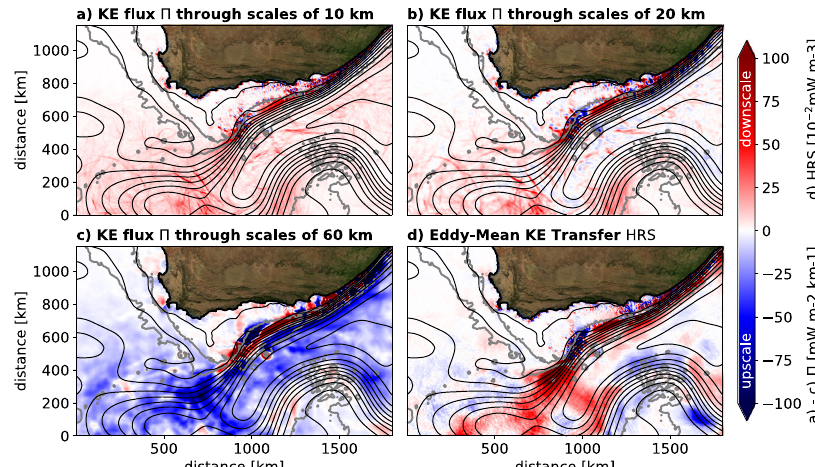
Fig. 4 Submesoscale fl ows strengthen shear-edge eddies and lee cyclones. The mean surface kinetic energy fl ux Π through horizontal scales of ( a ) 10 km, ( b ) 20 km, and ( c ) 60 km, as well as the mean surface eddy-mean kinetic energy transfer HRS d in INALT60. The quantities are computed based on 4-h mean output and averaged over periods when the Agulhas Current is not in a strong meandering state for the period 2012 – 2017. Negative values show upscale fl uxes to larger scales and positive downscale fl uxes to smaller scales. Black contours show the 2012 – 2017 mean SSH with an interval of 10 cm and grey contours the 300 m and 3000 m isobaths. For land areas, a satellite picture is shown 49